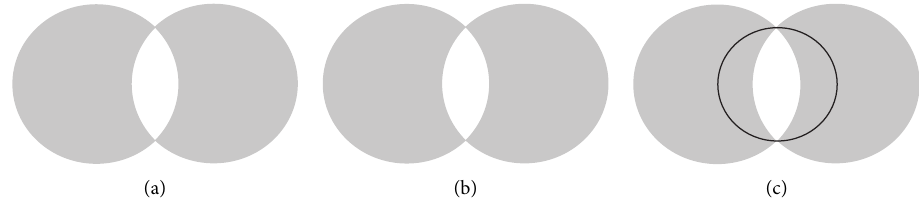
Figure 9: Schematic diagram of three-frame difference method. (a) D � A+ B. (b) E � B+C. (c) F � D+E.